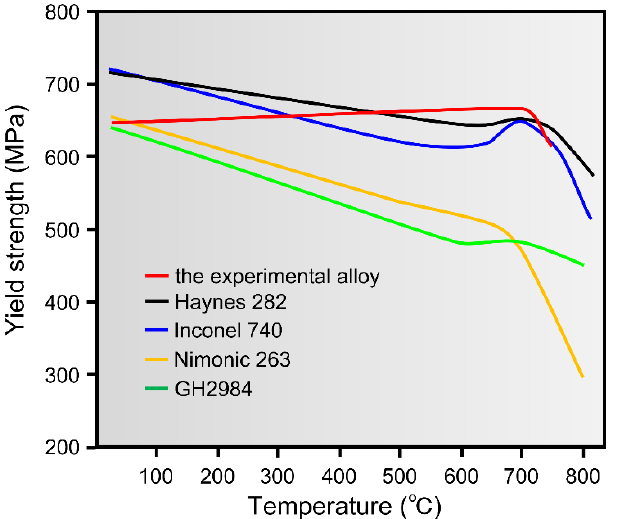
Figure 10. The yield strength as a function of temperature of various Ni-based/Ni-Fe-based alloys. During the tensile deformation, the deformation behavior of the experimental Ni-Fe- based alloy strongly depends on the temperature. At room temperature, well-defined slip bands were observed, indicating that most dislocations moved within at least two slip systems. Dislocation pairs bypass through the γ’ precipitates to minimize the antiphase boundary area created by the a/2<110> displacement of the superlattice. The dislocation loops around some γ’ precipitates indicate that the Orowan mechanism also occurred during tensile deformation at room temperature. When the tensile temperature increases to 700 °C, slip bands cannot be observed. It means the movement of dislocation is not confined to the slip bands. Extensive dislocation activities, including the bowing-out and looping process (Orowan mechanism) and the dislocation shearing of the γ’ precipitate were observed, leaving stacking faults in them (dislocation shearing mechanism) at this temperature. Hence, some γ’ precipitates acted as strong dislocation barriers and could pin the dislocation around them, which is the Orowan mechanism. Localized interfacial stress concentration could make the dislocation travel through the γ’ precipitates and create additional precipitate/matrix interfacial areas, finally increasing the interfacial energy, which is chemical strengthening. Some γ’ precipitates acted as weak dislocation barriers and the dislocation could shear them and leave stacking faults inside, which is the dislocation shearing mechanism. Similarly, at 750 °C, both Orowan and dislocation shearing mechanisms can be observed. The precipitation strengthening mechanism depends on the size of the precipitation particles. At a small size, dislocation shearing will be dominant, while dislocation bowing will be dominant at a large size. This means the size of the γ’ precipitates did not change significantly during tensile testing at 700 °C and 750 °C. For the interaction between precipitates and dislocations, there exists the critical size of pre- cipitates for the transition from Orowan looping to precipitate shearing. According to the commonly used equations [14,15], the critical size of the γ′ precipitates can be calculated as follows: For Orowan looping, 𝜏 𝑜 = 0.9 + [ln(2𝜋𝑟/𝑏)] 3/2 [ln(𝐿/𝑏)] 1/2 [ 𝐾 𝑏(𝐿 − (𝜋/2)𝑟)] (1) For precipitate shearing,